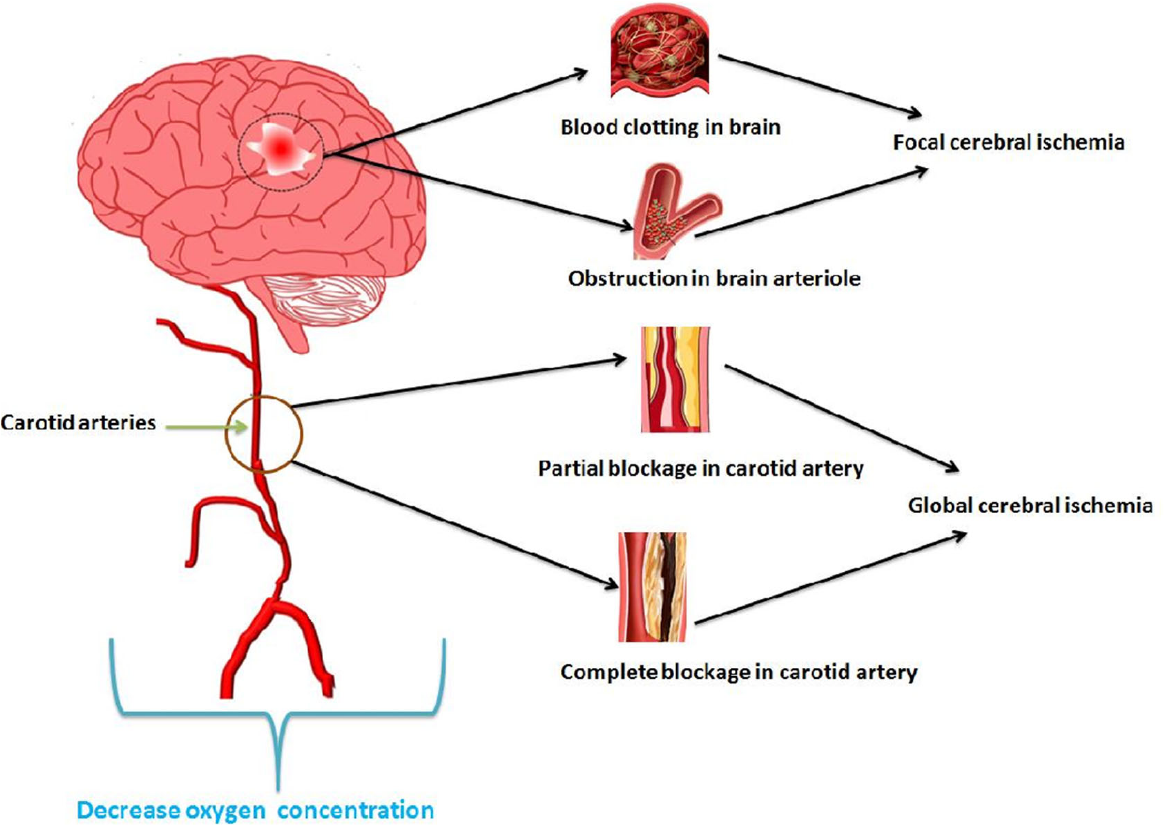
Figure 3. Cerebral ischemia developed due to decreased oxygen concentration in carotid arteries.